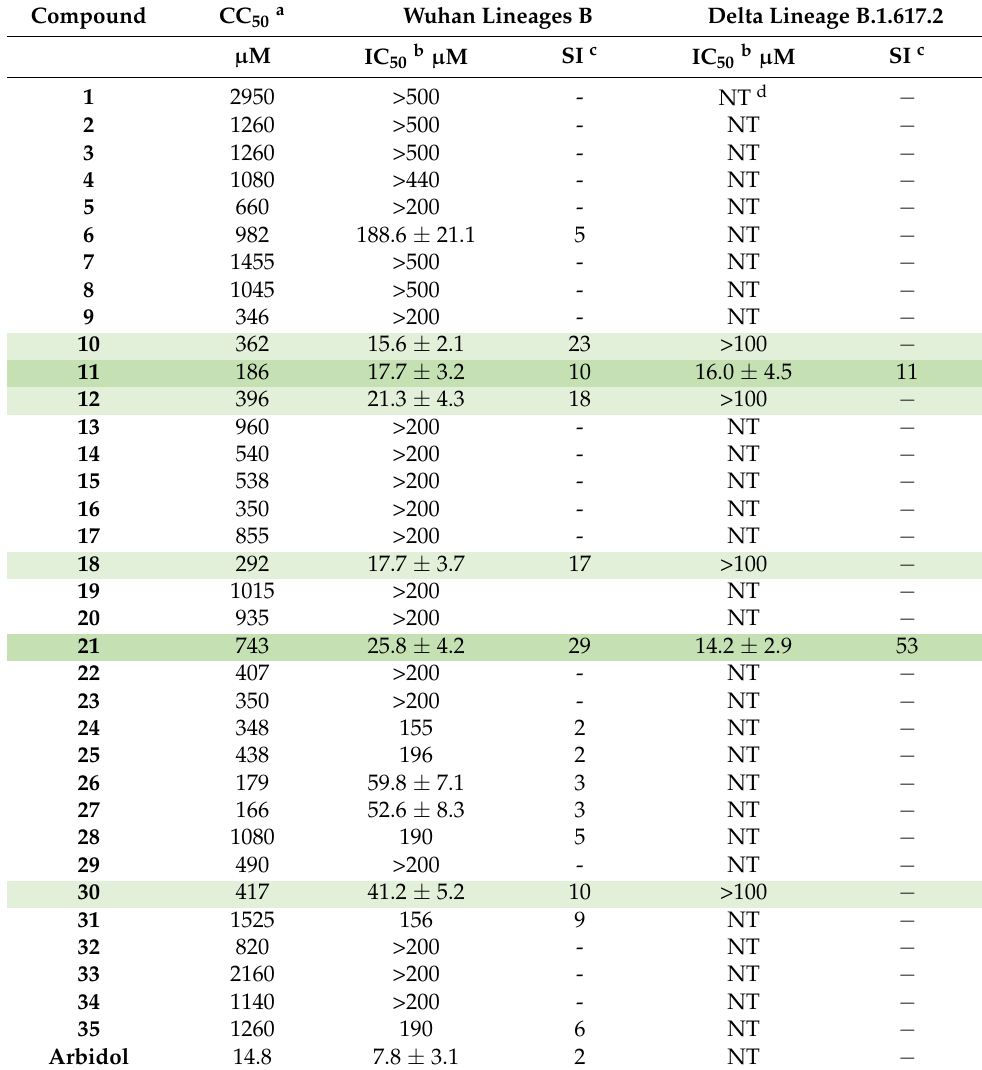
Table 1. Inhibitory activity against pseudoviruses pseudotyped with S protein of Wuhan lineages B and Delta lineage